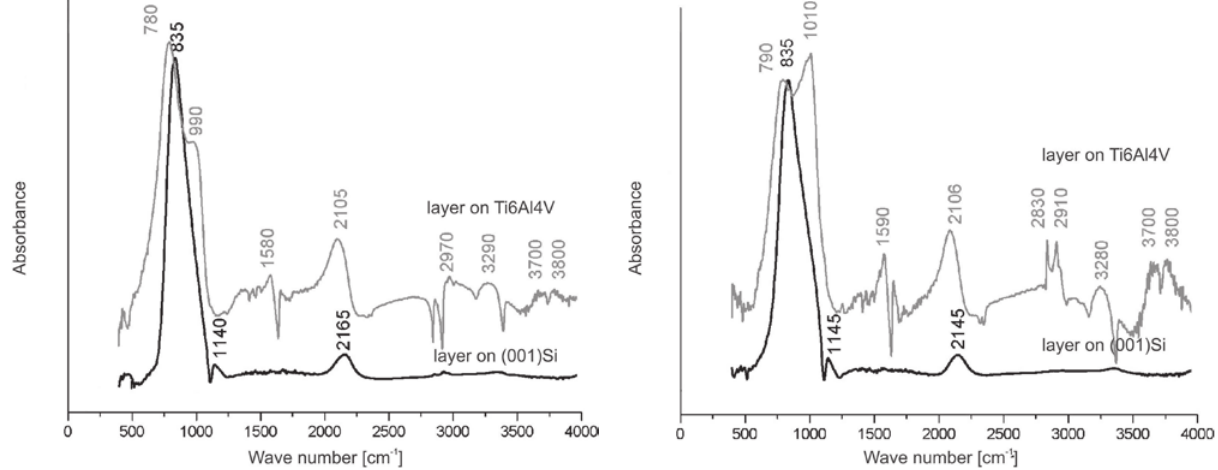
Fig. 7: FTIR spectra for Si x N y (H)/(001)Si and Si x N y (H)/alloy synthesis in series 1.